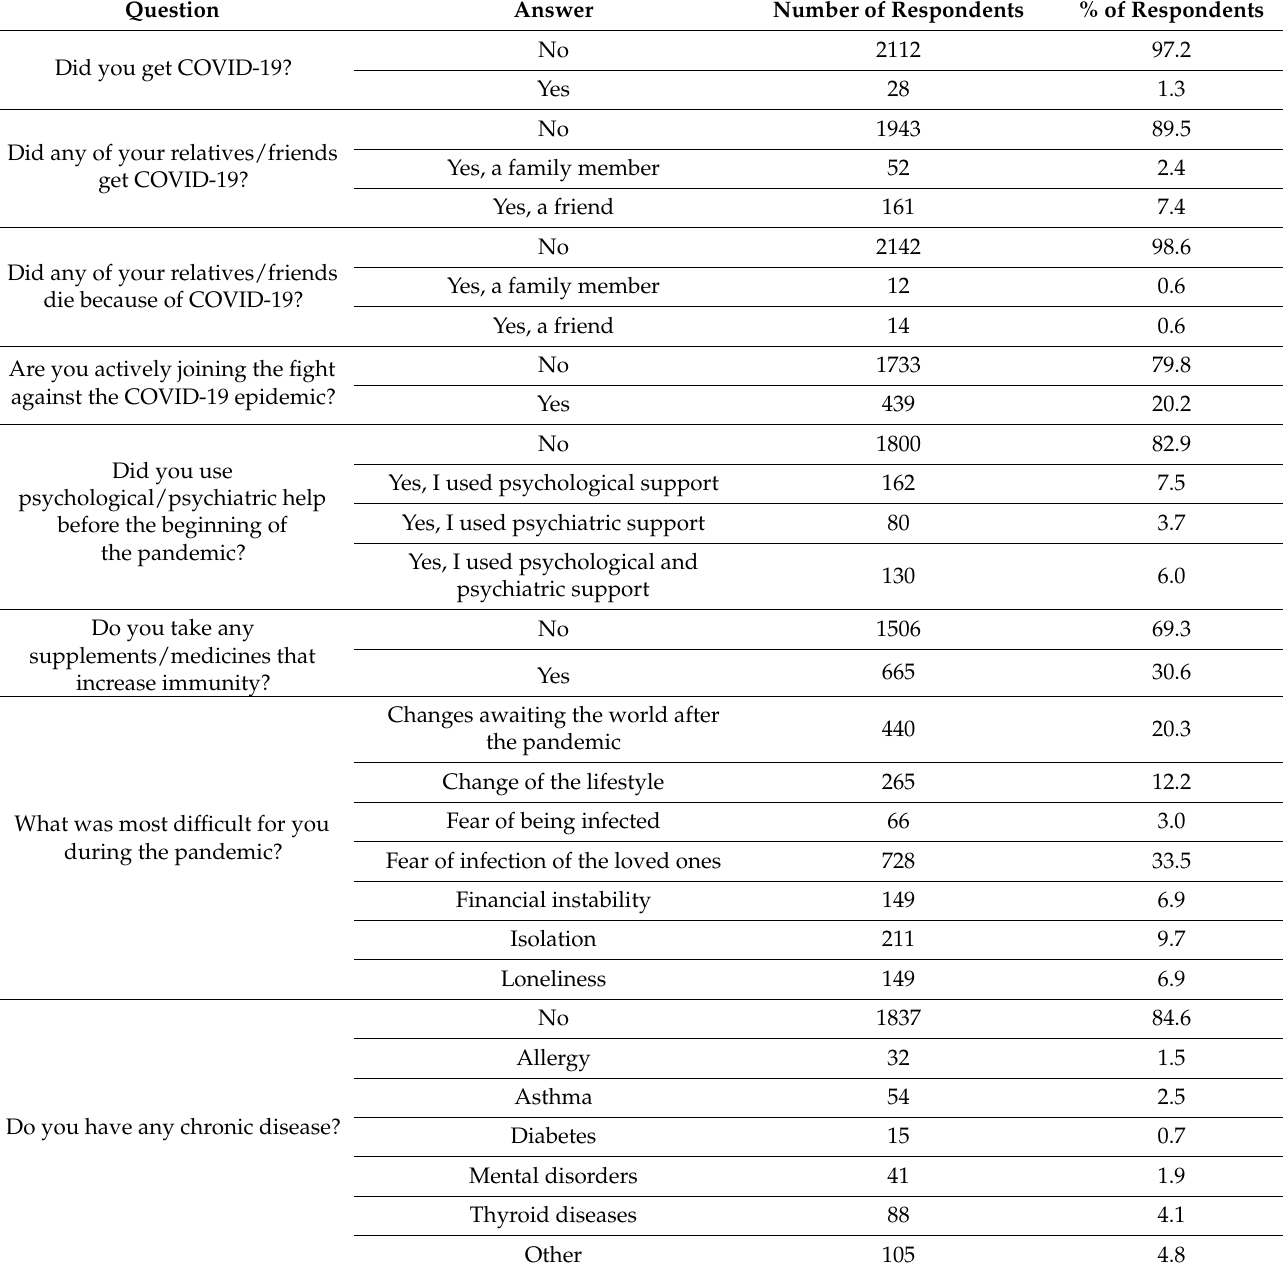
Table 3. Factors associated with the health status of